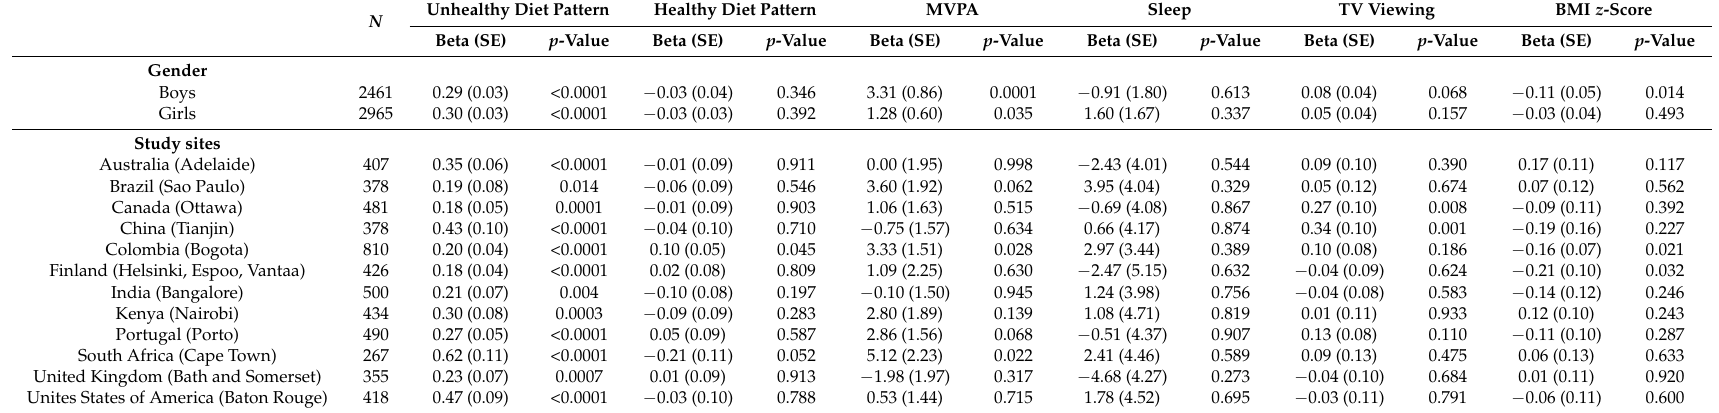
Table 4. The association between emotional eating a and outcome variables b in gender-stratified c and site-stratified d